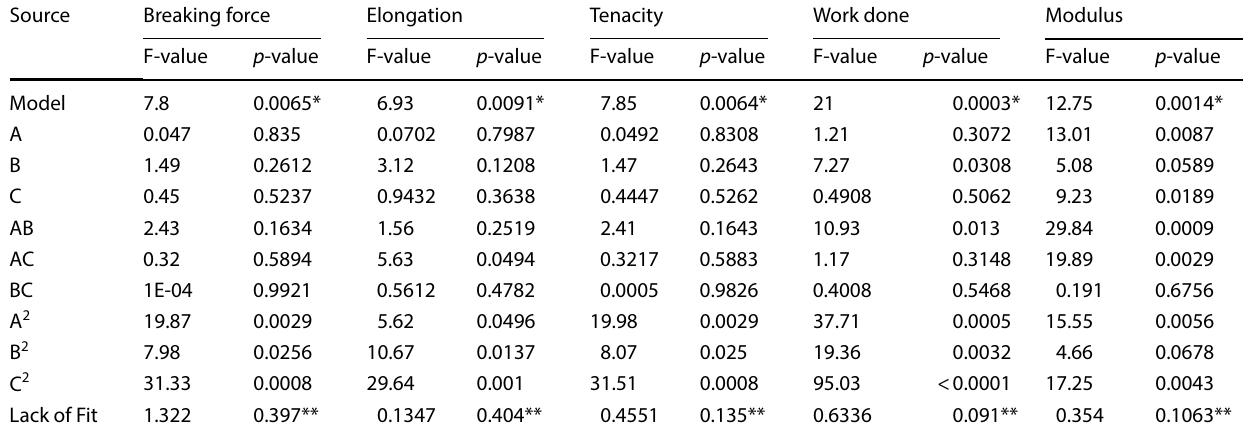
Table 9 Analysis of variance for response surface quadratic model of alkali-treated Y.alpina bamboo fiber